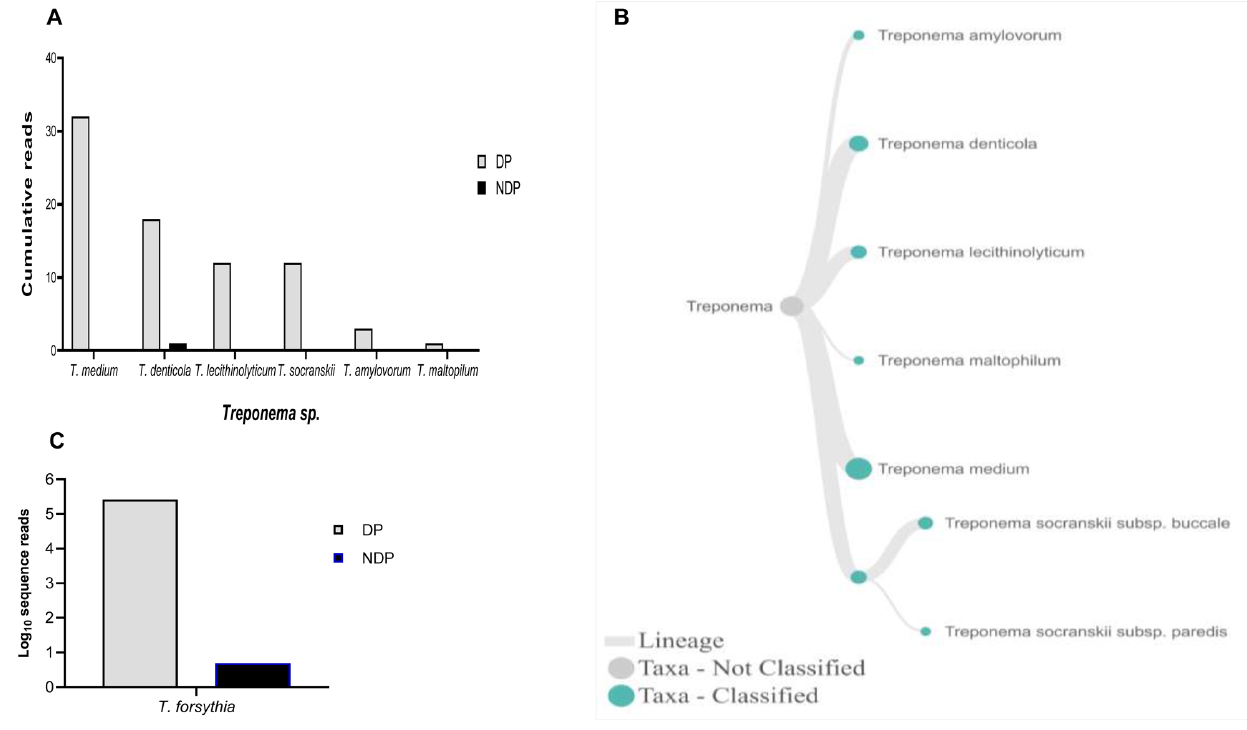
Figure 4. Treponema and Tannerella sp . in pooled subgingival microbiota samples obtained from diabetic (DP) and non-diabetic (NDP) patients. Relative abundance of ( A ) six Treponema sp; and ( B ) Dendogram showing the variability of Treponema sp ., across pooled samples. ( C ) Tannerella forsythia